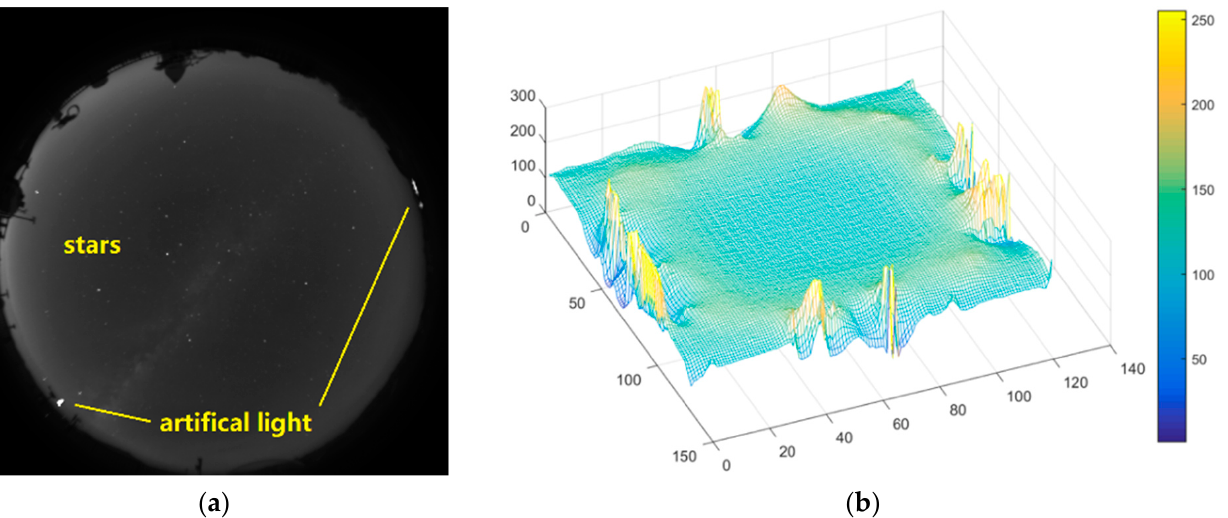
Figure 2. ( a ) Original size (1024 × 1024 pixels) airglow image; ( b ) three-dimensional view of feature map. The color bar indicates the weight.